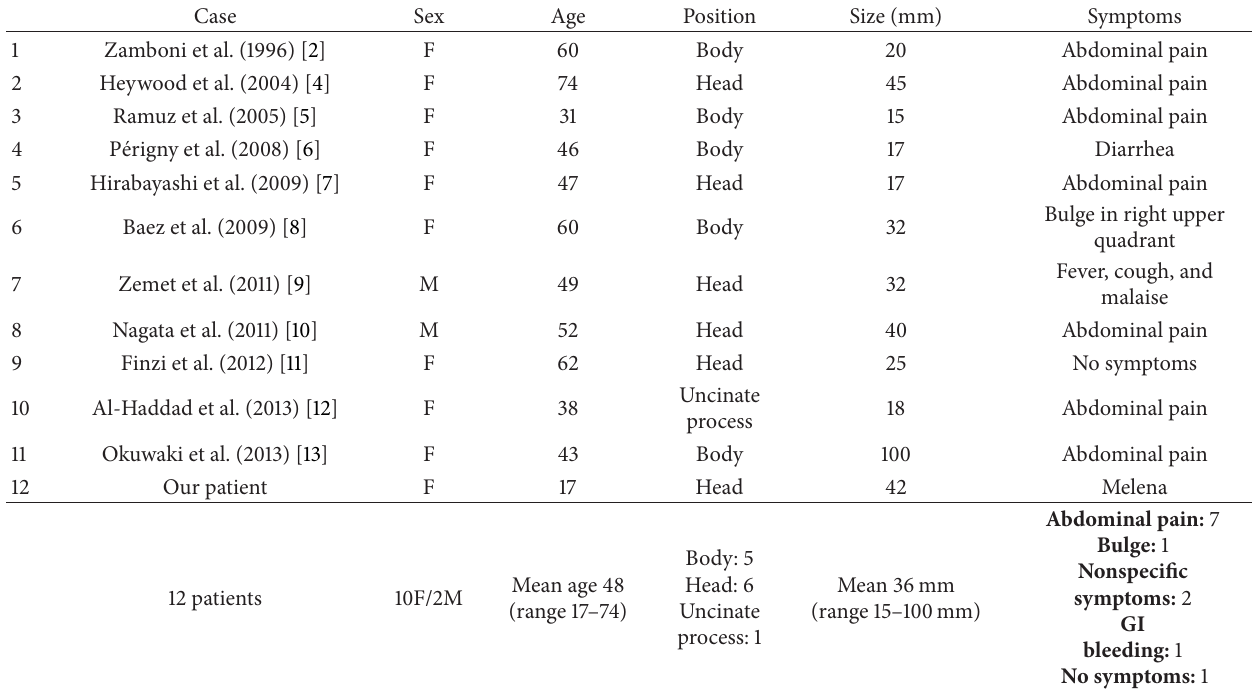
Table 1: Reported cases of pancreas PEComas and symptoms at